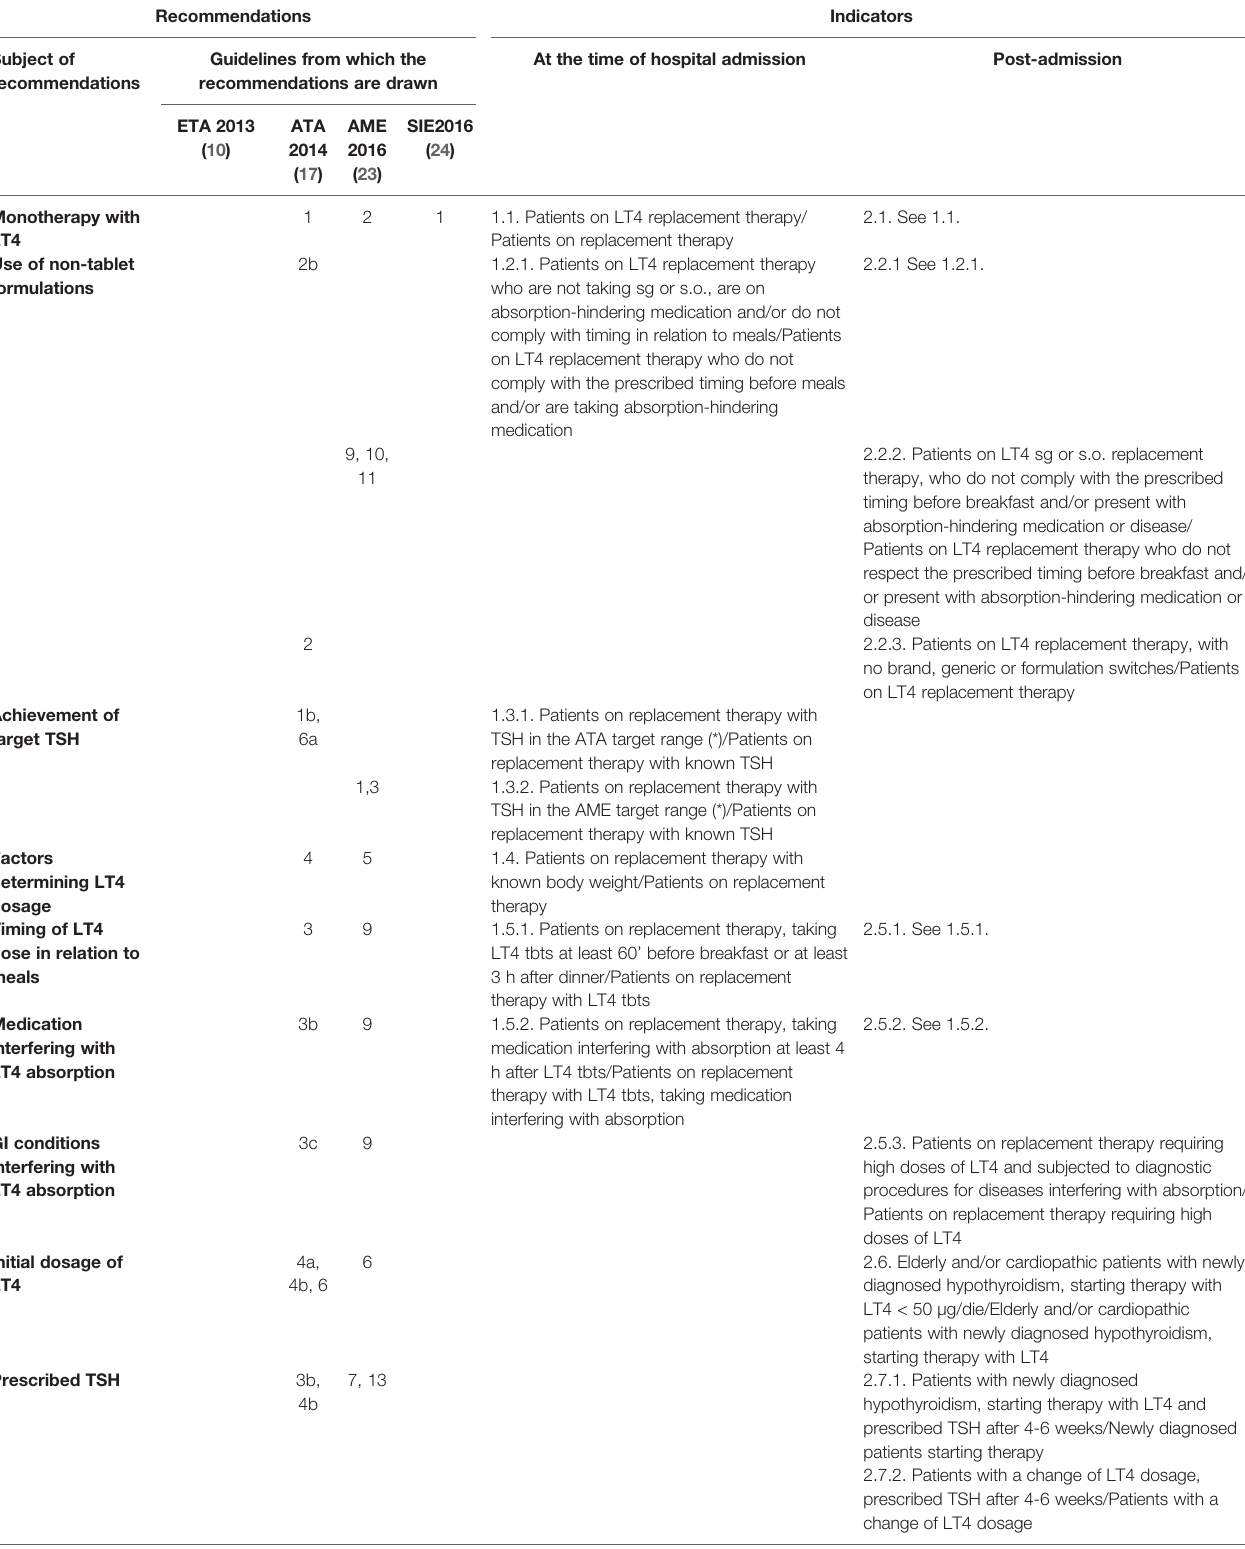
TABLE 1 | Recommendations and indicators. The selected recommendations are numbered as in the respective publications from which they are